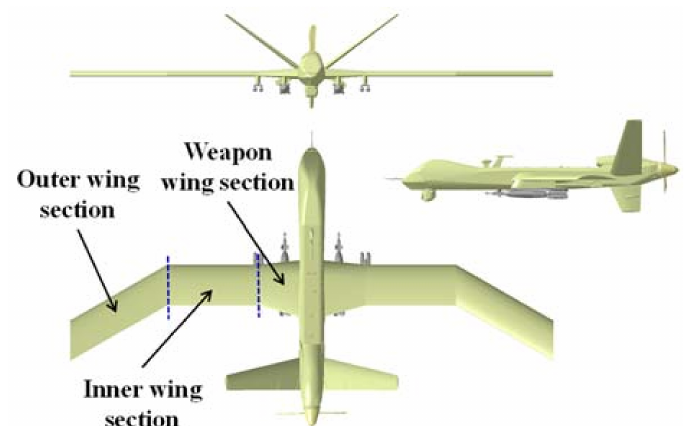
Figure 3. Schematic diagram of the bionic multi-section variable-sweep wing UAV with a conven- tional layout. The wing can be divided into the following three sections: weapon wing, inner wing, and outer